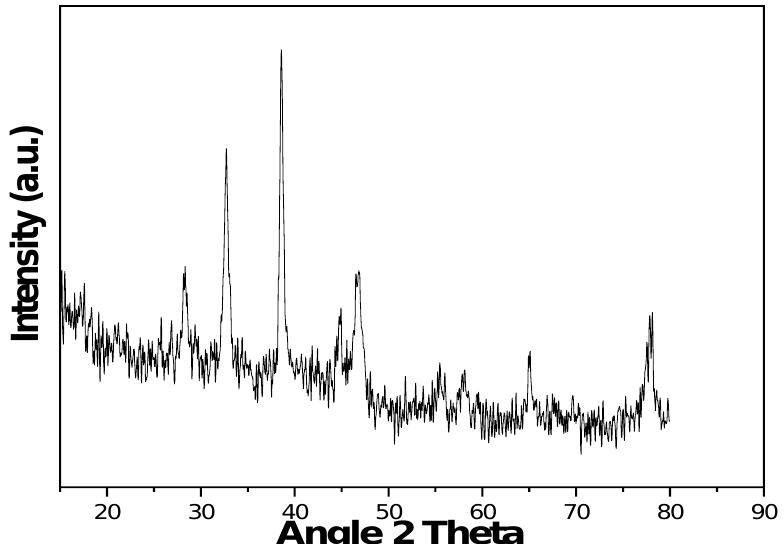
Molecules 2023 , 28 , x FOR PEER REVIEW Figure 3. XRD analysis of the silver nano-powder. Figure 3. XRD analysis of the silver nano-powder.